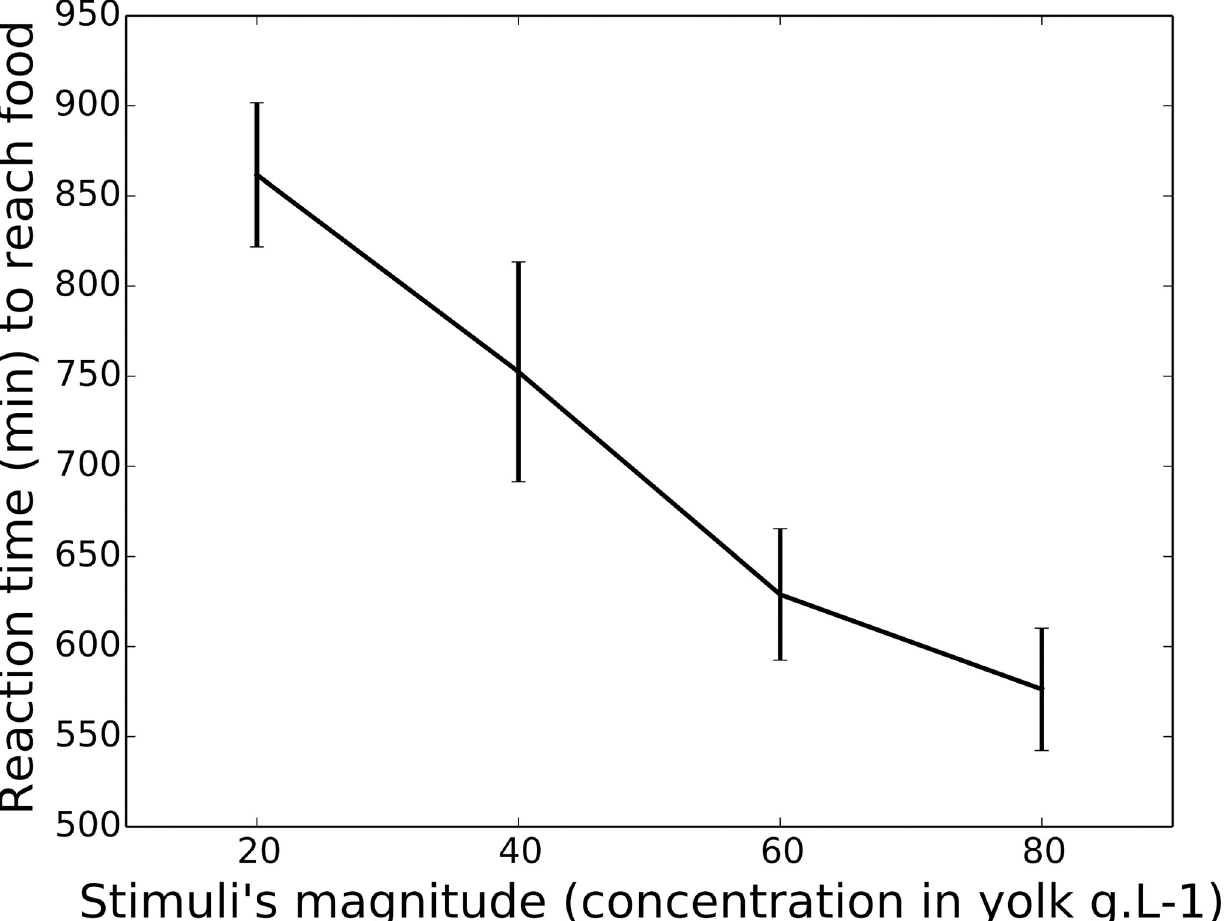
Fig 2. Empirical results from the slime mould experiment. Decreasing latencies to reach a food source as a function of the magnitude of the equal alternatives. X-axis presents the concentration in egg yolk of equal food sources (20, 40, 60, 80 g.L − 1 ). Y-axis presents mean latency to reach a food source, in minutes. Bars show 95% confidence intervals. 50 slime moulds were tested for each magnitude for a total of 200 slime moulds.